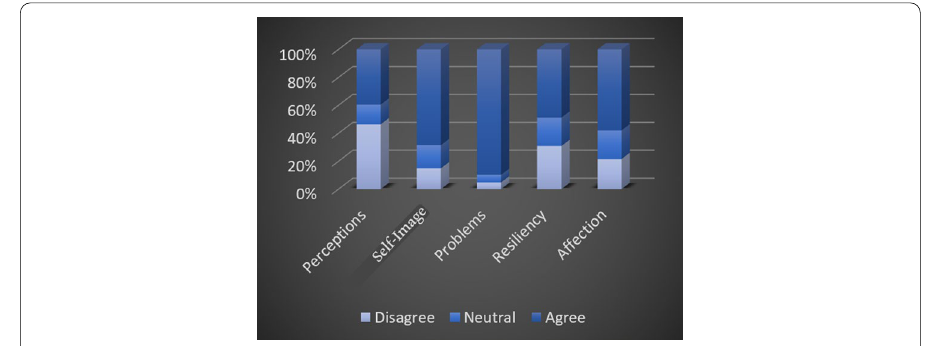
Fig. 2 Percentage of responses to